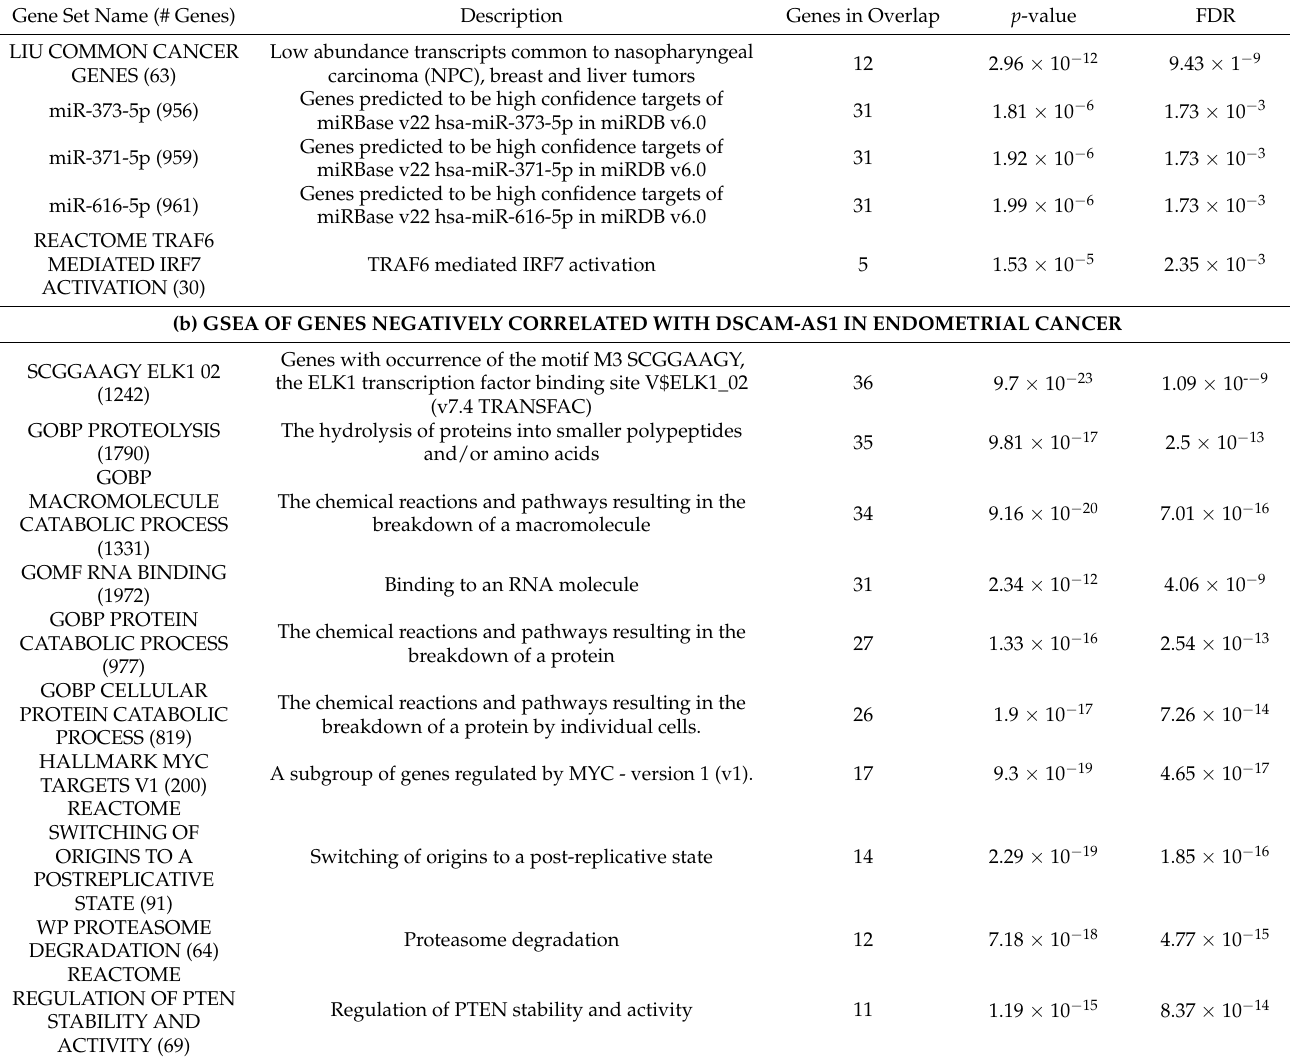
Table 1. ( a ) Gene set enrichment analysis (GSEA) of genes positively correlated with DSCAM-AS1 in endometrial cancer (GSEA, MSigDB v7.5.1) [30]. FDR = false discovery rate. ( b ) Gene set enrichment analysis (GSEA) of genes negatively correlated with DSCAM-AS1 in endometrial cancer (GSEA, MSigDB v7.5.1) [30]. Shown are the 10 most significant overlaps. FDR = false discovery